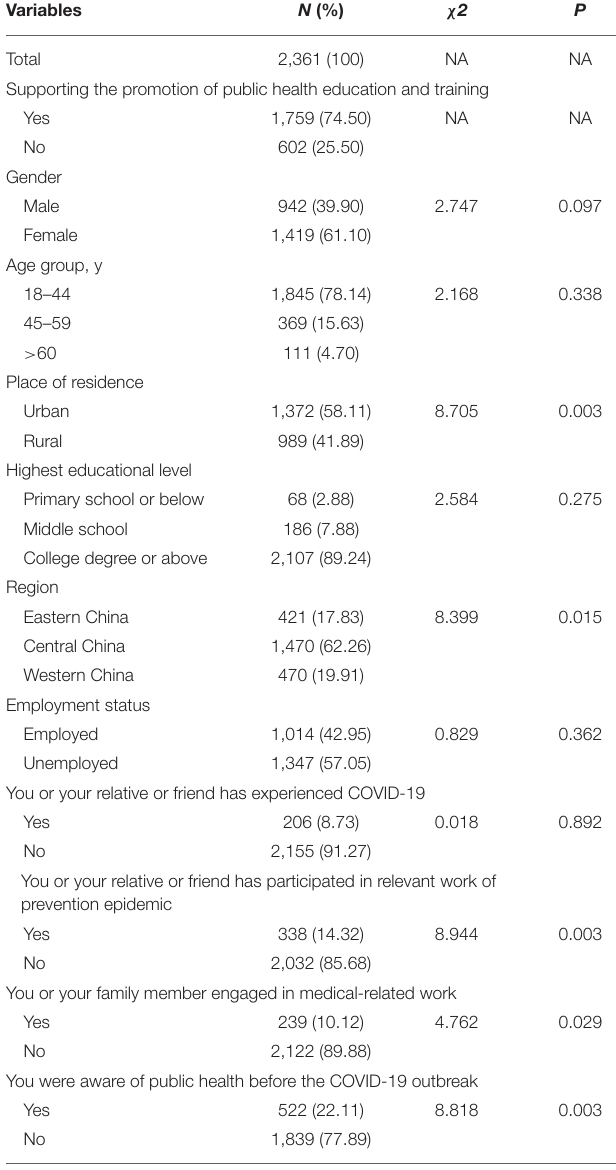
TABLE 1 | Statistical description of study samples: univariate analysis of the differences of residents’ attitudes of developing public health professionals.